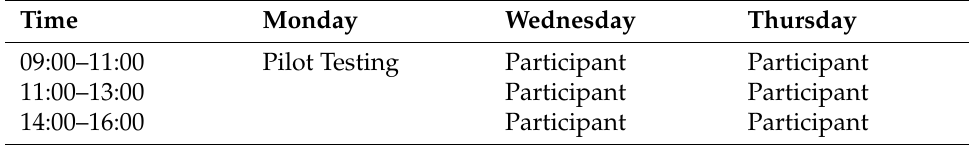
Table 1. Schedule of